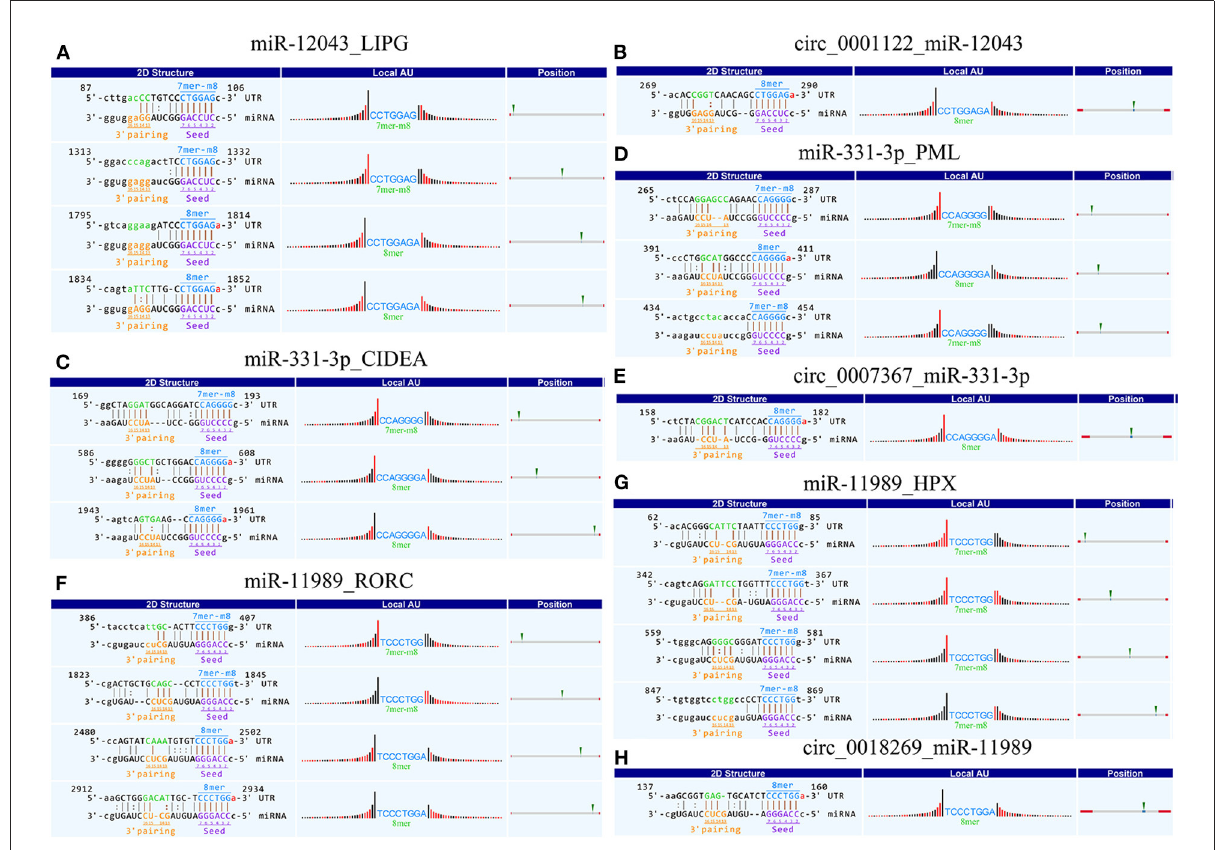
FIGURE4 Schematic diagram of circRNA_miRNA_mRNA binding sites. (A–H) Targeted binding sites between circRNAs_miRNAs_mRNAs: pairing at bases 2–7 and 13–16 is particularly important for site recognition and is highlighted in brown. 8mer: 2–8 nucleotides matched perfectly, where 1 was A. 7mer-m8: 2–8 nucleotides matched perfectly, where 1 was not A. “|” denotes a perfect match. “:” denotes G:U pairing. “” denotes a mismatch. Local AU: Schematic diagram of AU weight on both sides of the seed site. This feature affects the accessibility of the site. The red bar